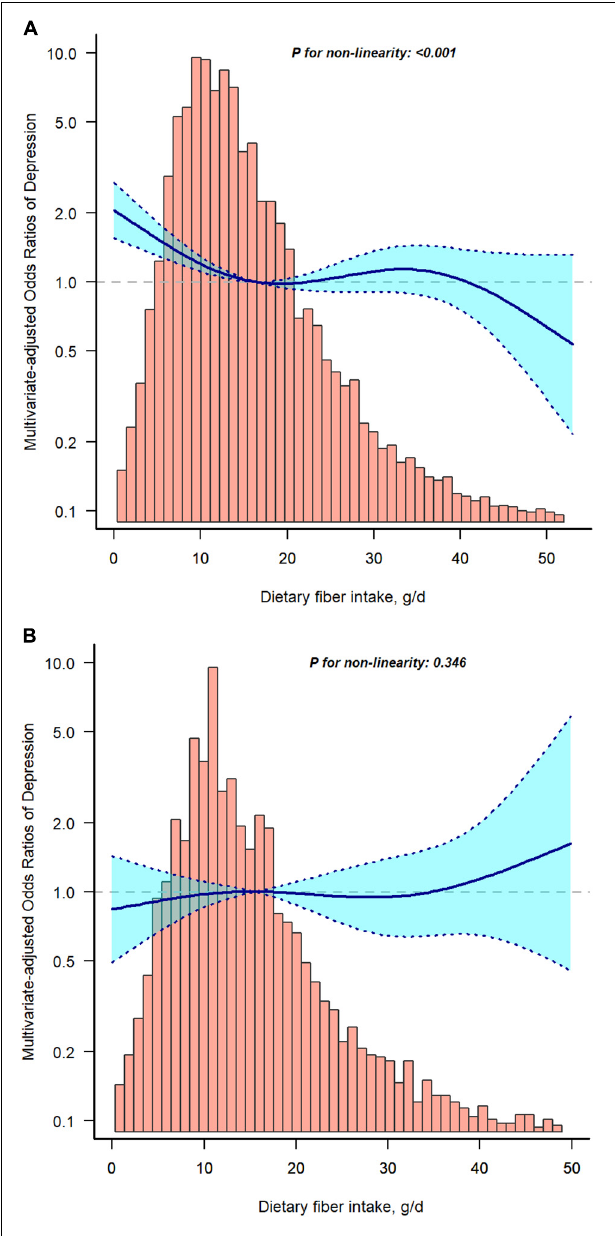
FIGURE 2 | Restricted cubic spline model of the odds ratios of dietary fiber intakes with depression without type 2 diabetes (T2D) (A) or with T2D (B) . Adjusted for age, gender, race/ethnicity, body mass index (BMI), educational level, poverty to income ratio (PIR), smoking status, alcohol consumption, physical activity, hypertension, and total daily energy intake. The dashed lines represent the 95% confidence intervals.